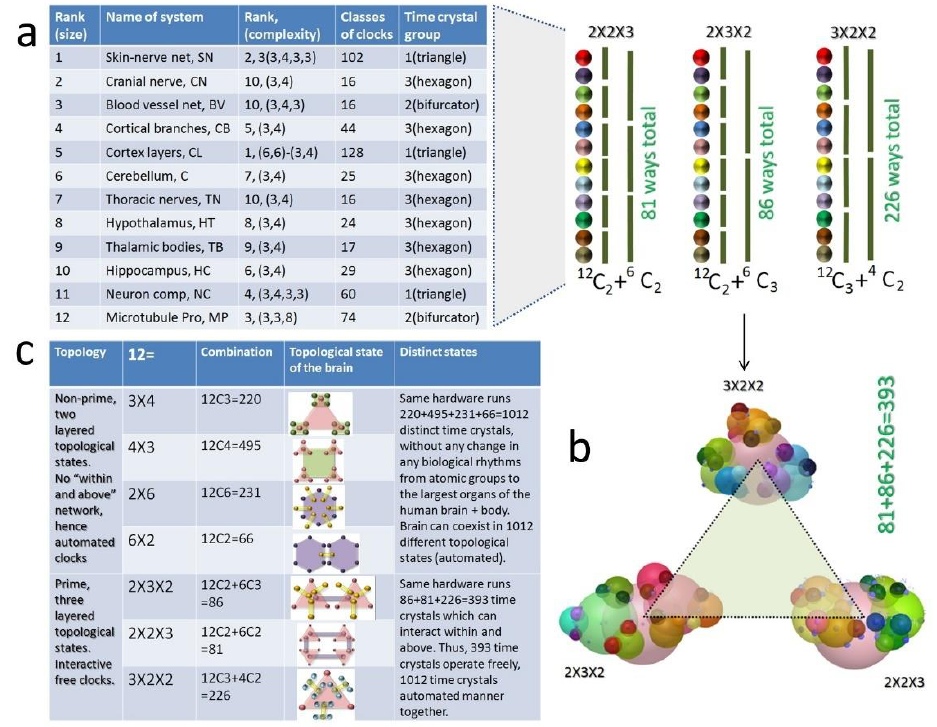
Figure 5. ( a ) A table shows 12 triplet of triplet band compatible brain components. Complexity based ranking are shown in the third column. Within the parenthesis, layered clock architecture is noted as (3,4,3,3). It means, top layer has 3 clocks, then each clock has 4 clocks inside (3 × 4 = 12), each of the 12 clocks have 3 clocks inside, we get 3 × 12 = 36 clocks. Each of the 36 clocks have 3 clocks inside, hence code (3,4,3,3) means 108 clocks in a four layered clock architecture. To the right of this table, in the panel ( b ) 2 × 2 × 3, 3 × 2 × 2 and 2 × 3 × 2 are shown. The top panel shows how 12 brain components could form groups and integrate information in three distinct combinations of key brain components.